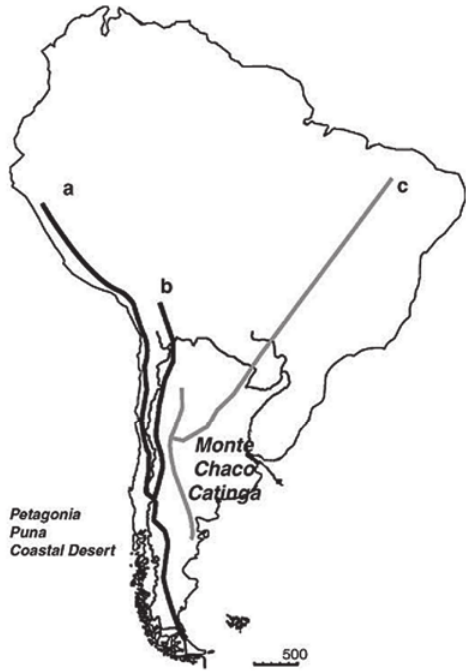
Fig. 24 - South American map with biotic tracks related to the xeric natural areas (modifi ed from Roig-Juñent et al. 2003, 2006).